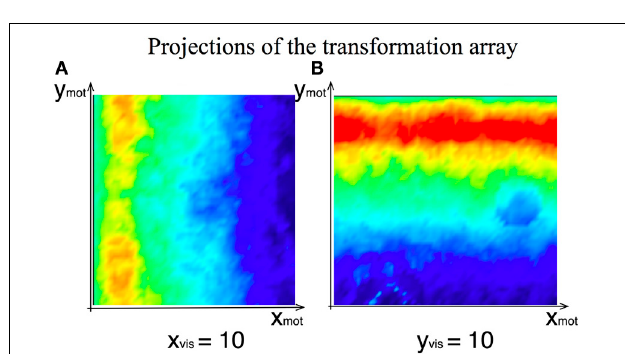
FIGURE 8 | Two exemplar projections of the learned 4D transformation array between the visual and the motor intention DNFs of the agent. (A) Weights’ strength at the given visual-intention DNF horizontal position as function of motor intention field coordinates (overlayed projections along y mot ). (B) Weights’ strength at the given visual-intention DNF vertical